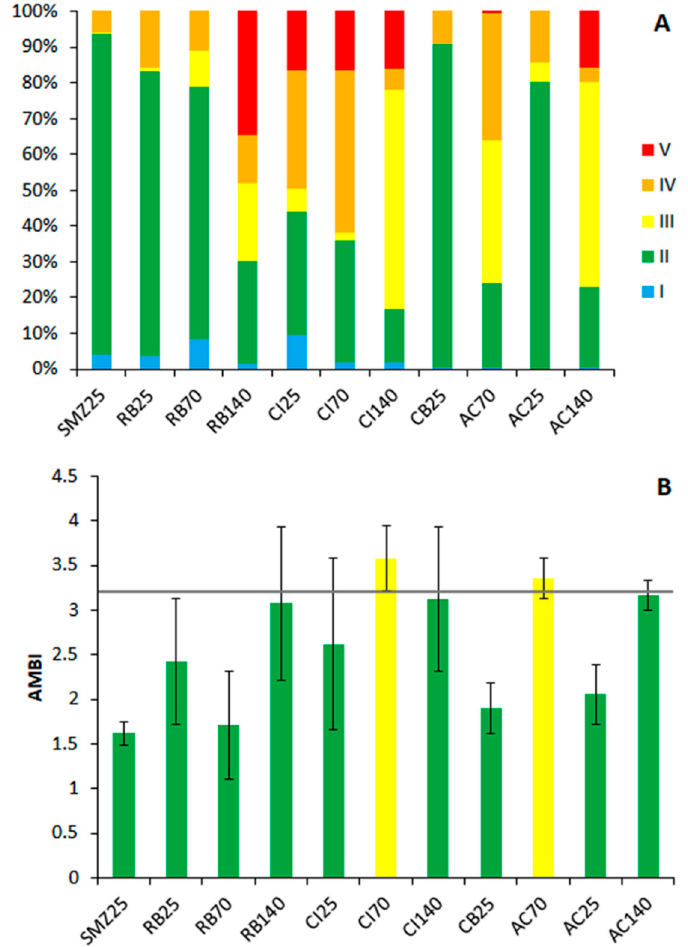
Figure 3. ( A ) Percentage of the different Ecological Groups (I–V). ( B ) The AMBI values at each station (horizontal line: the threshold between Good and Moderate status).